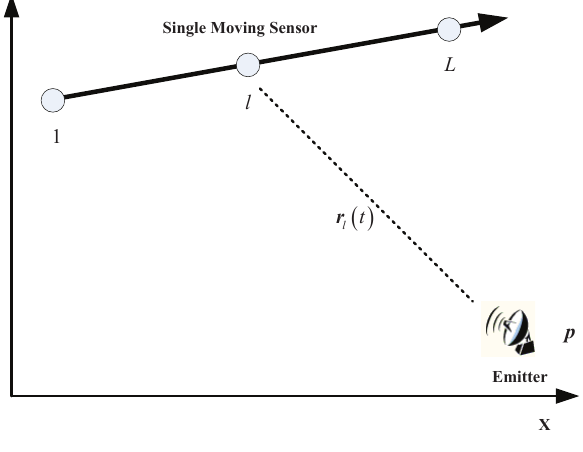
Figure 1. The localization